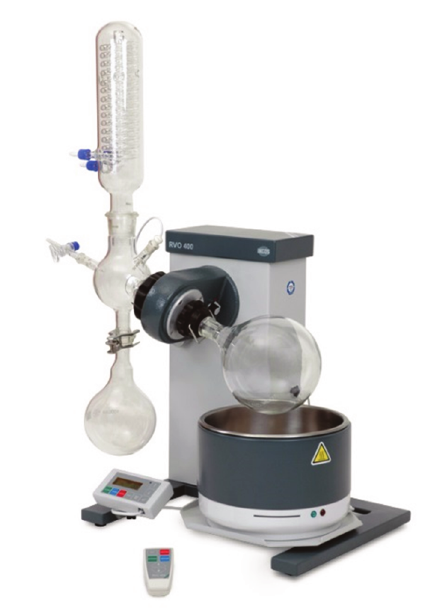
Fig. 1. The set up used to perform the transesterification reaction